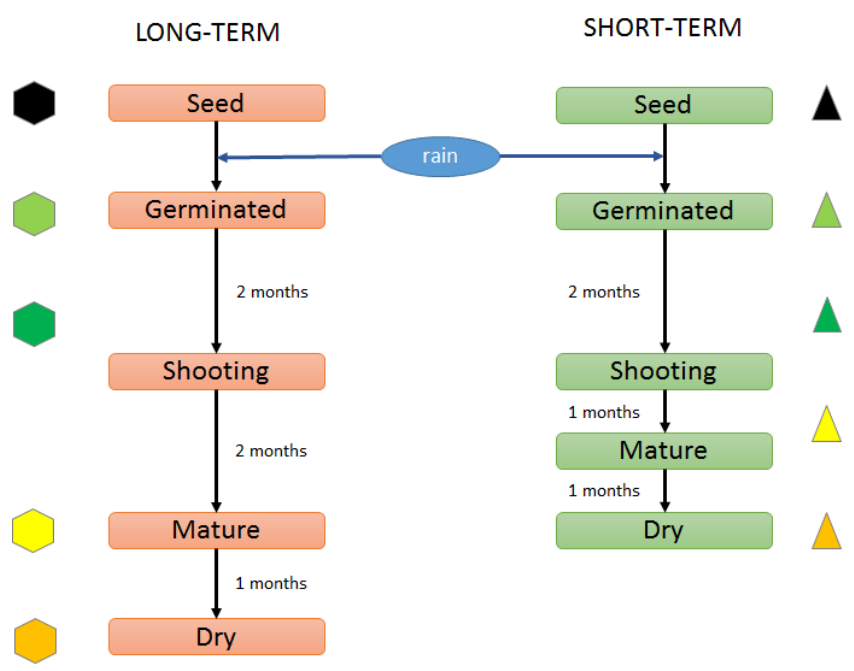
Figure 8. Crops transition